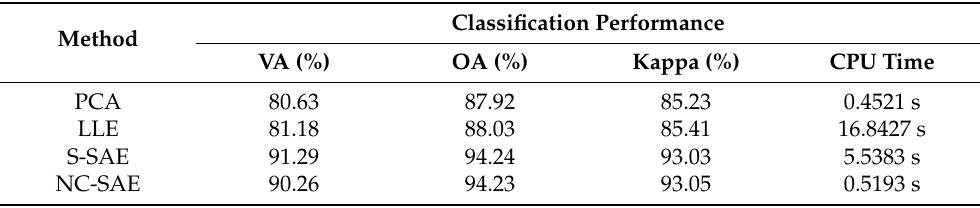
Table 4. Comparison of the classification performance using CNN classifier under various data compression